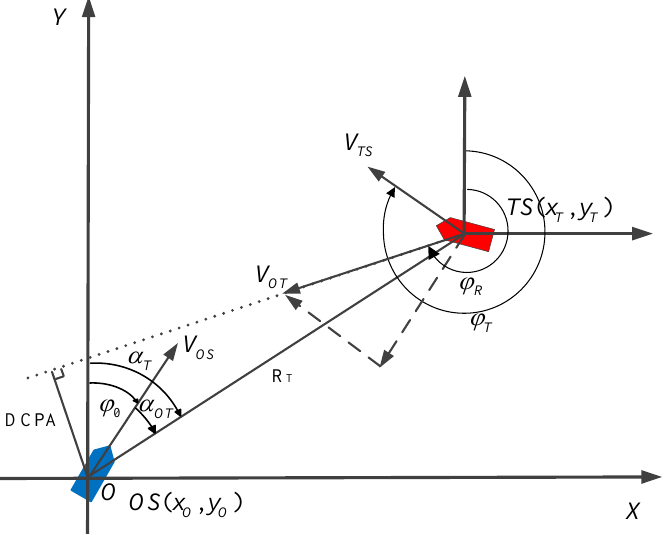
Figure 2. Motion parameters of two ships in a typical encounter situation.